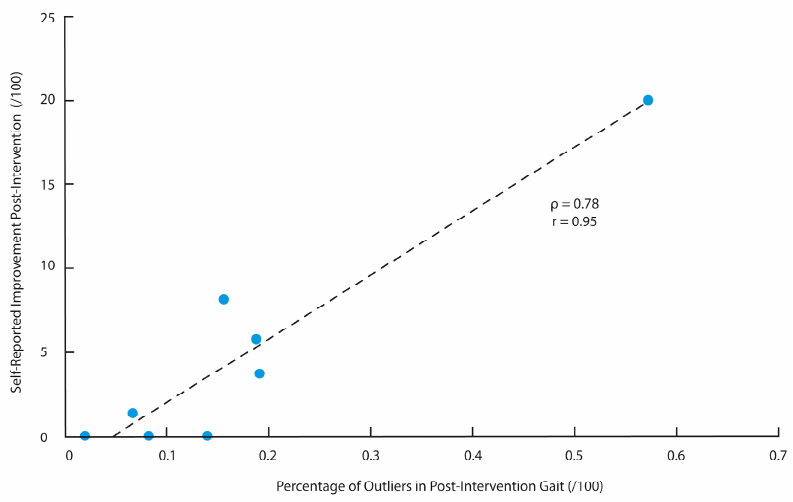
Figure 3. The percentage of outlier in post-intervention data displayed a large association with the self-reported improvement in post-intervention (i.e., change in Knee Injury Osteoarthritis Outcome Scores subscales): Spearman rank correlation ( ρ ) = 0.78 and Pearson correlation coefficient (r) = 0.95.